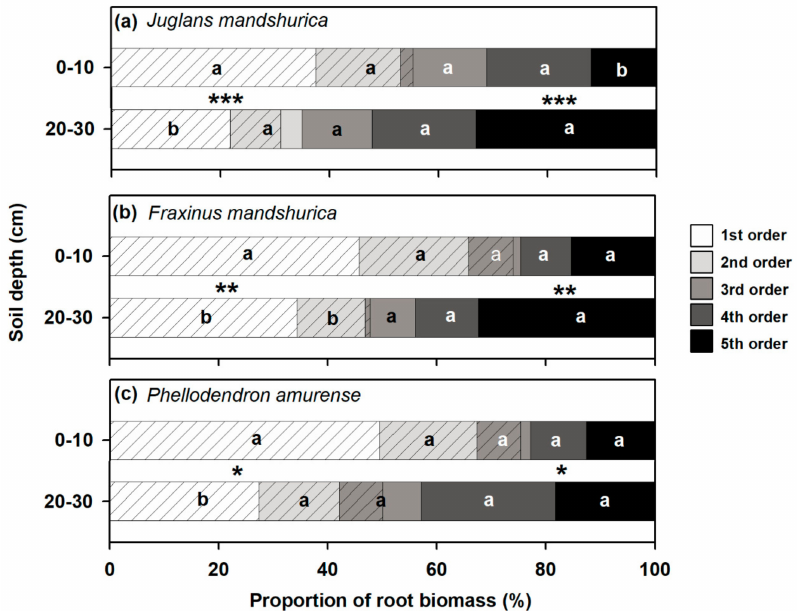
Figure 2. Proportions of root biomass (PRB) in di ff erent root orders to total fine root biomass (first five root orders) at surface (0–10 cm) and subsurface (20–30 cm) soil layers in Juglans mandshurica ( a ), Fraxinus mandshurica ( b ), and Phellodendron amurense ( c ), respectively. Di ff erent lowercase letters indicate significant di ff erences ( p < 0.05) in PRB within a root order between soil layers according to Fisher’s least significant di ff erence (LSD) test. Asterisks indicates significant di ff erences (*** p < 0.001, ** p < 0.01, * p < 0.05) in the PRB of absorptive (with diagonal lines) or transport (without diagonal line) fine roots (based on Table 1) between soil layers according to Fisher’s LSD test,